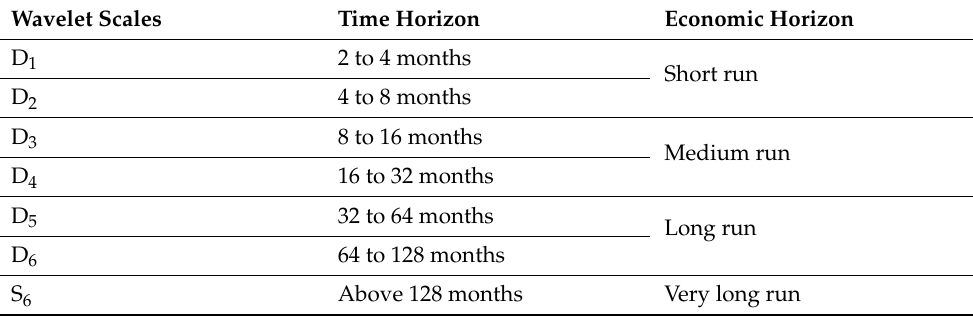
Figure 1. Decomposition of all variables. Panel ( a ): Growth, ( b ): Inflation, and ( c ): Interest rate. Source: Author’s own contribution. Table 5. Transformation of wavelet scales into different time horizons.